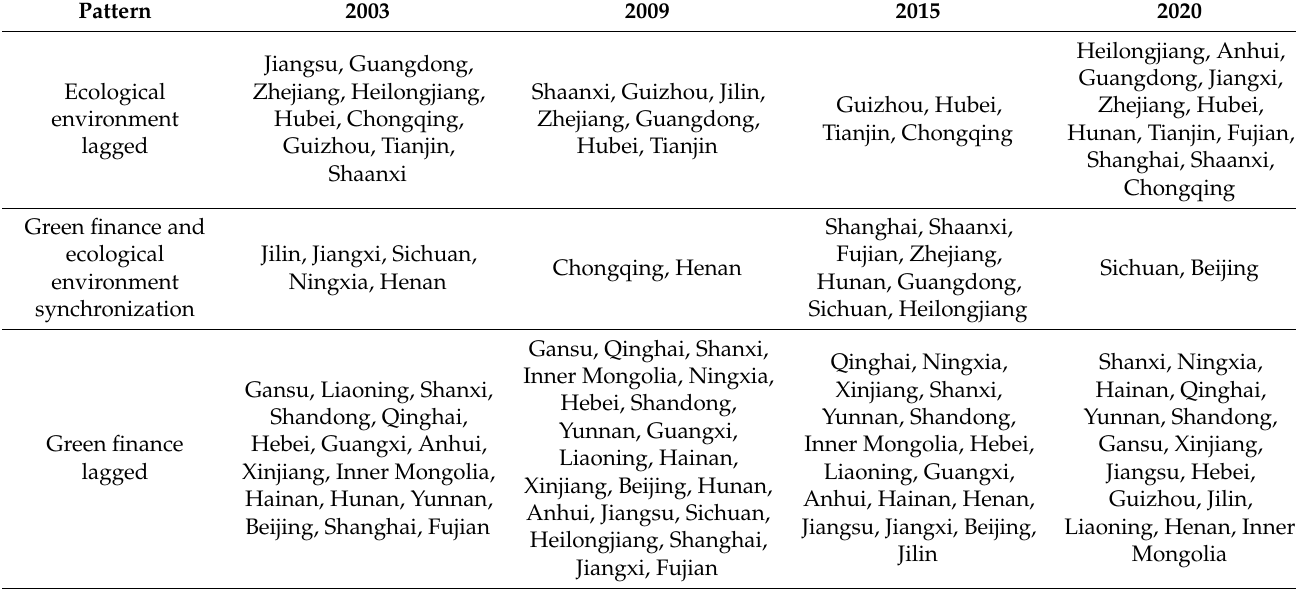
Table 4. The pattern of CCFE in the years 2003, 2009, 2015, and 2020,